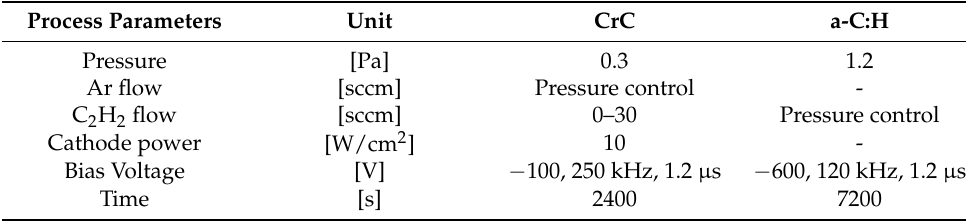
Table 1. CrC and a-C:H film depositin parameters.